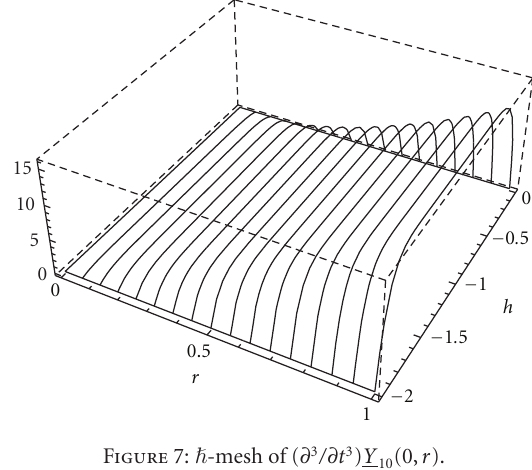
Figure 7: (cid:2) -mesh of ( ∂ 3 /∂t 3 ) Y